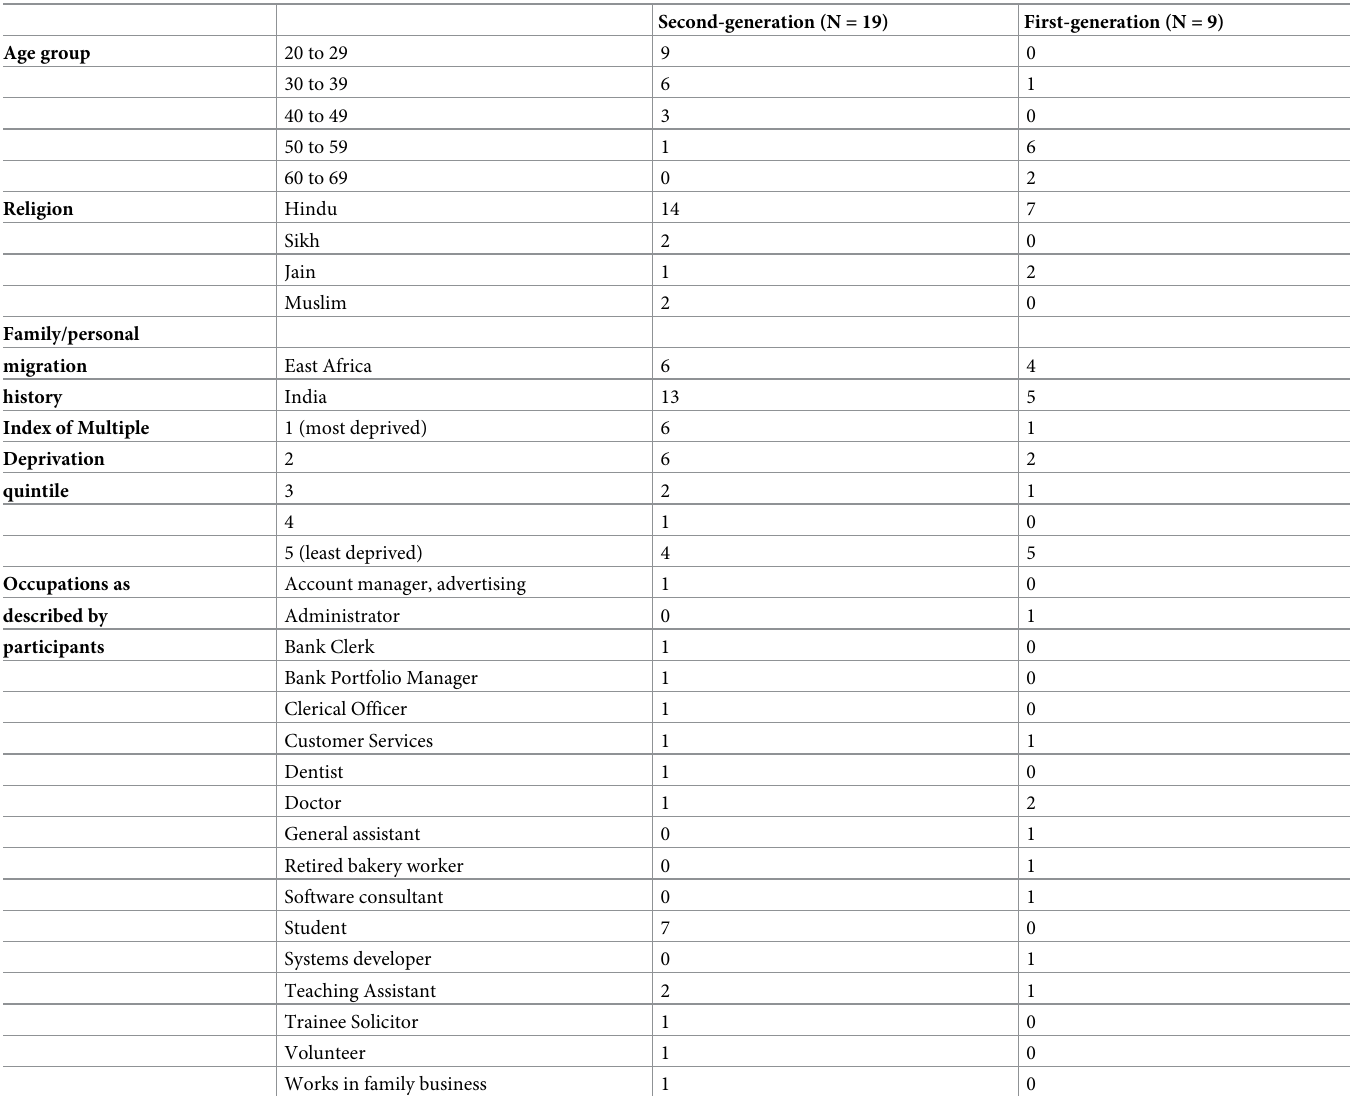
Table 1. Characteristics of first and second-generation